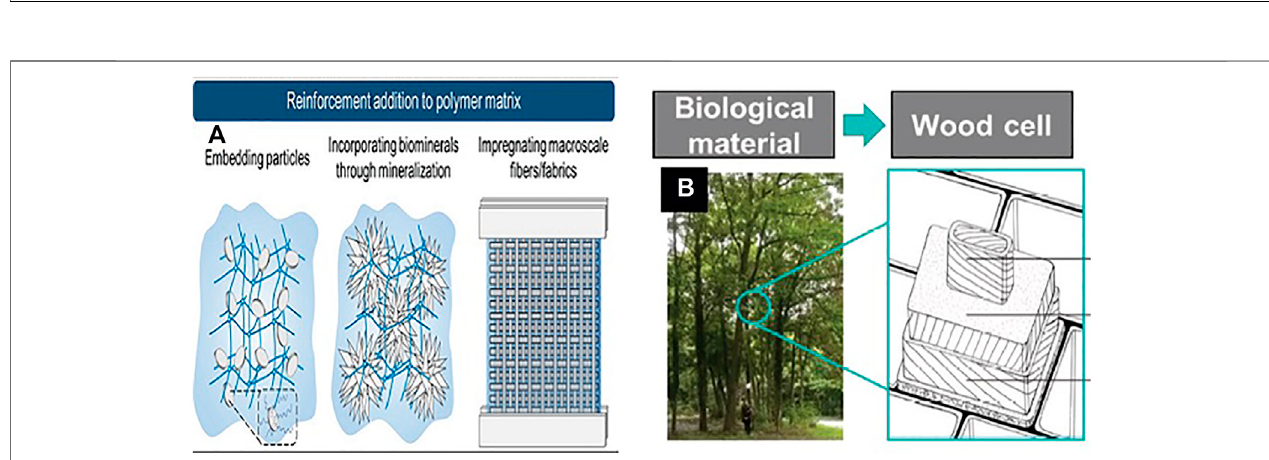
FIGURE6 |(A) Schematic outlineoflater methods pointed to develop stiff and stretchable tough hydrogels (Ji and Kim, 2021) Copyright 2021, John Wiley & Sons Inc. (B) Impression of the wood-inspired design model and mechanical performance of the fi ber-reinforced composites comprising a multilayer cylindrical